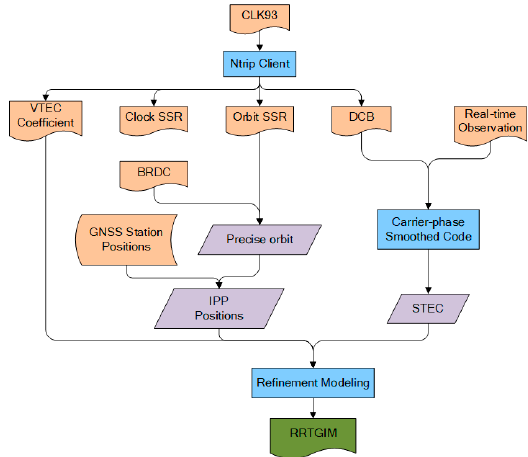
Figure 4. The procedure of refinement modeling.